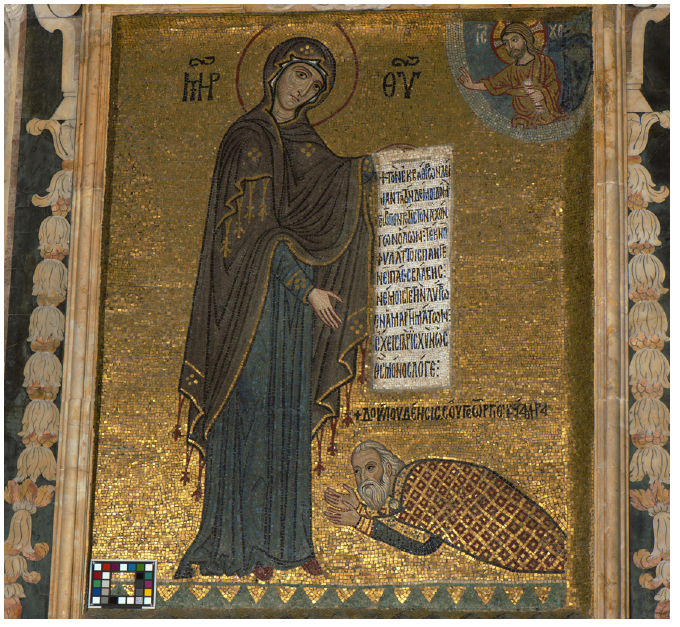
Figure 1: Palermo, St. Mary of the Admiral, Dedication panel, 12 th century mosaic wall: George of Antioch prostrate at the foot of the Virgin Mary (photo R. Deiana).